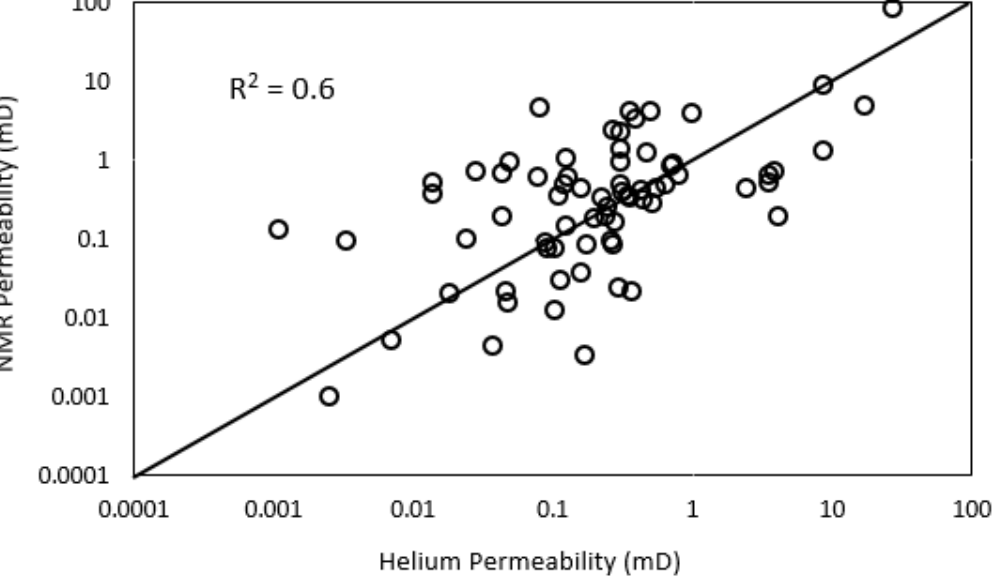
Energies 2019 , 12 , x FOR PEER REVIEW Figure 16. NMR-derived permeability versus core-measured permeability using T 2 LM . Figure 16. NMR-derived permeability versus core-measured permeability using 𝑇 2𝐿𝑀 .